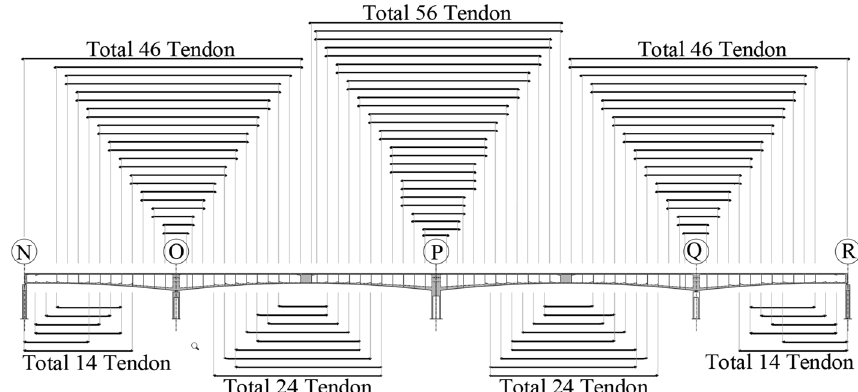
Fig. 4 Longitudinal prestressing layout of El-Warrak Bridge (“cantilever” and “continuity” tendons)